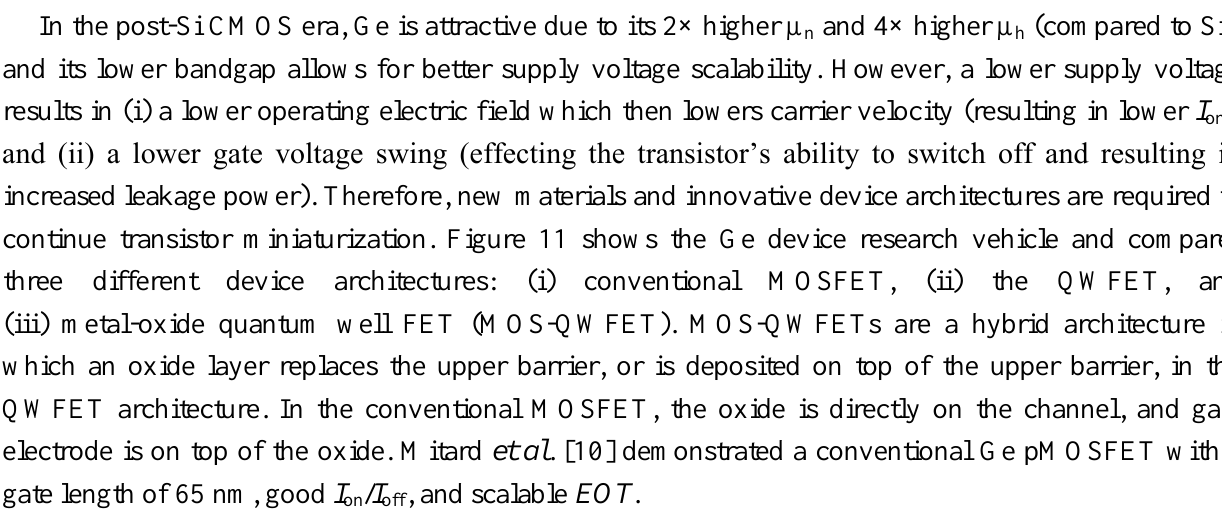
Figure 11. Device research vehicle for Ge on Si for low-power logic, and comparison of MOSFET, QWFET, and MOS-QWFET